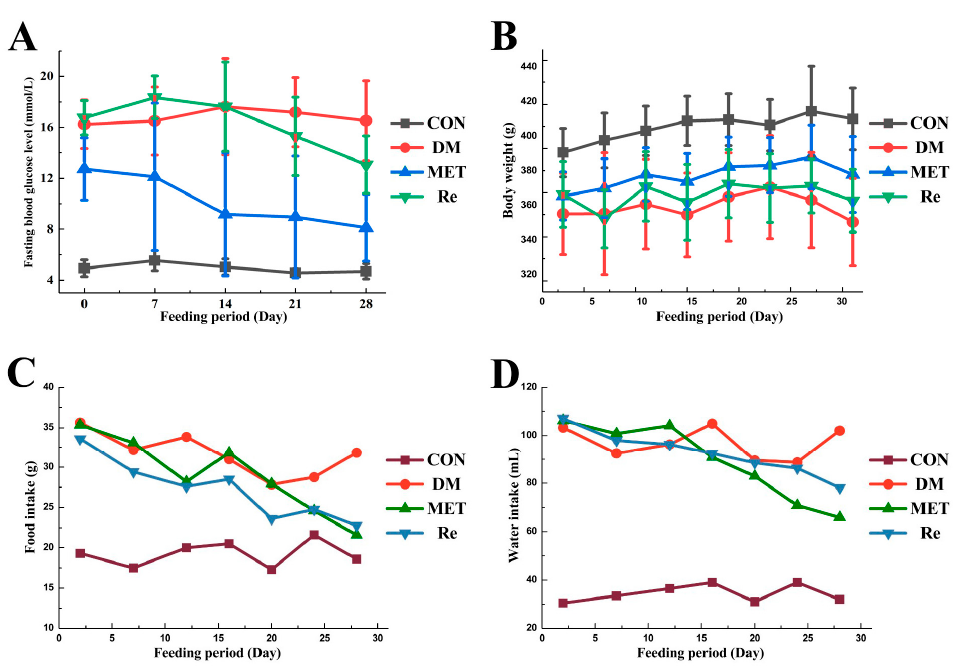
Figure 1. Effect of ginsenoside Re on fasting blood glucose level ( A ), body weight ( B ), food ( C ), and water ( D ) intake in T2DM rats.